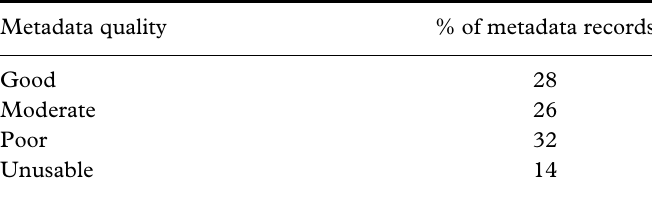
Table 4. Metadata quality in the HLSI project prior to